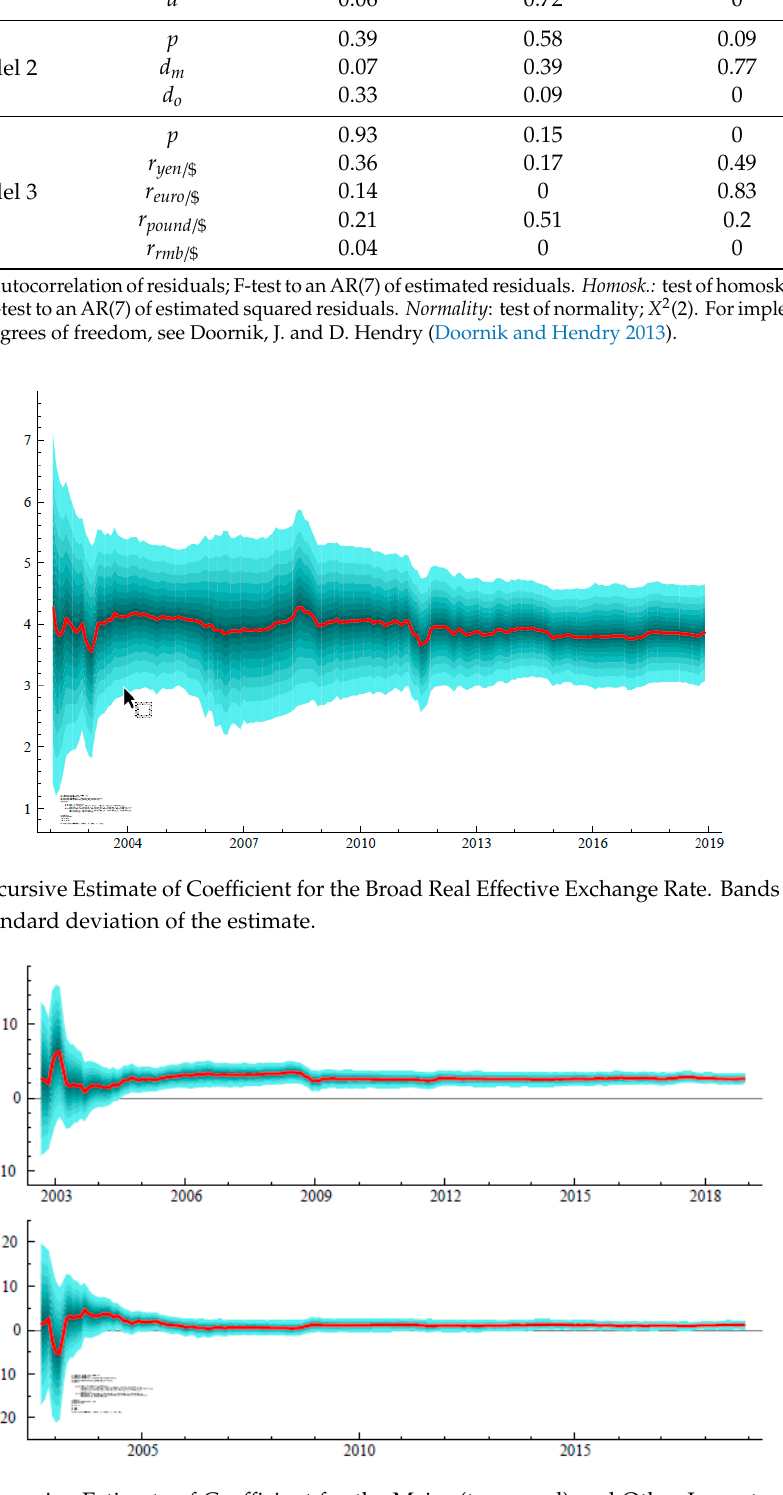
Figure 7. Recursive Estimate of Coefficient for the Major (top panel) and Other Important Trading Partners (bottom panel) Real Effective Exchange Rates. Bands represent twice the standard deviation of the estimate.